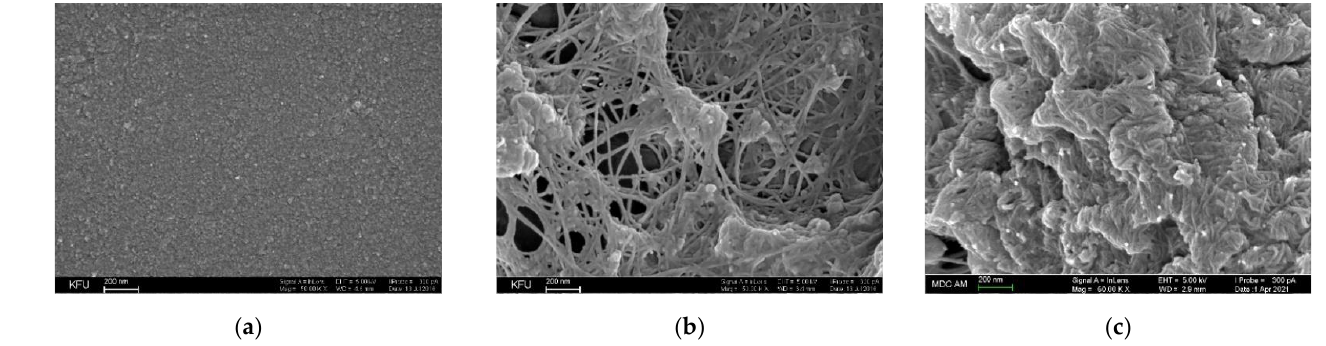
Figure 5. SEM images of bare GCE ( a ), f-SWCNTs/GCE ( b ) and polyBCP/f-SWCNTs/GCE ( c ).